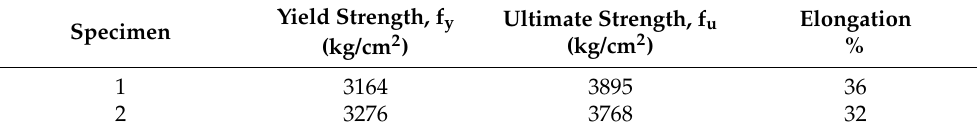
Table 1. Results of the tension tests on the steel. Specimen